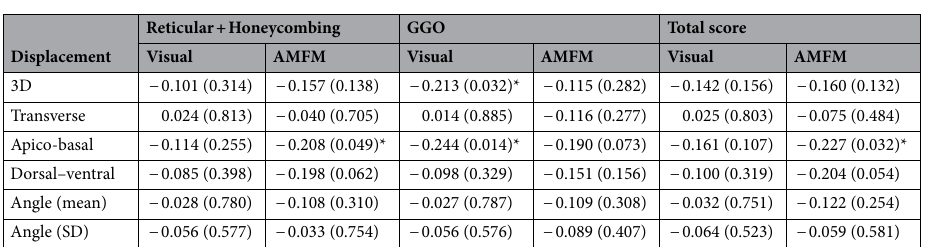
Table 4. Correlation coefficient (r) between IPF score and magnitude, angle of displacement vectors. Numbers in parenthesis are P values. P values with asterisk* indicate to be statistically significant. AMFM adaptive multiple features